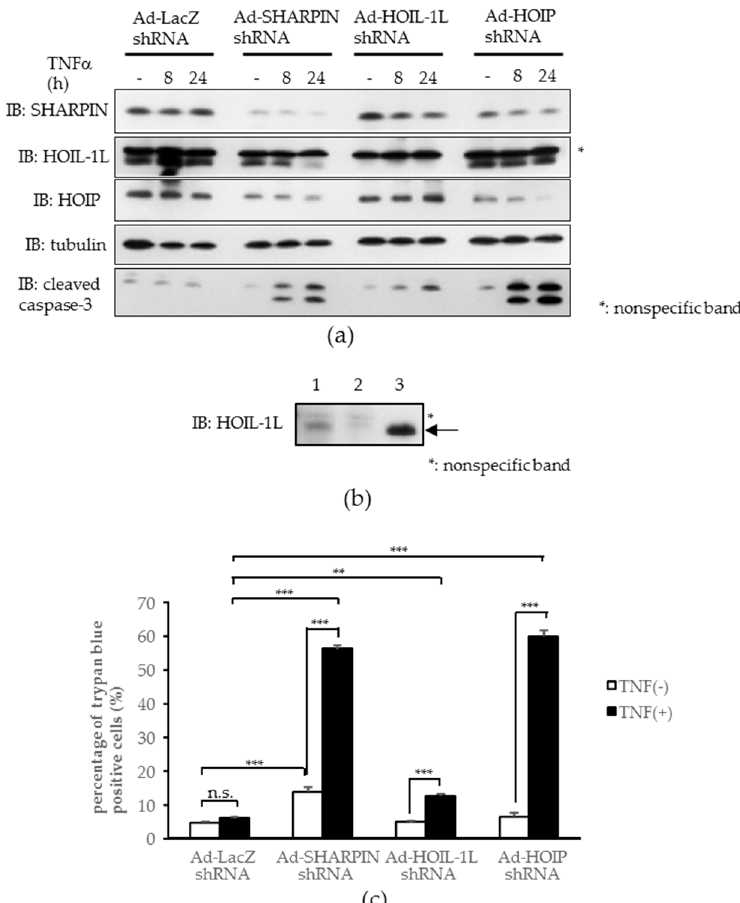
Figure 4. LUBAC insufficiency increases to tumor necrosis factor- α (TNF α )-induced apoptosis in Hepa1-6 cells. ( a ) Immunoblotting of each LUBAC component and cleaved caspase-3. Asterisks: non-specific bands; ( b ) Immunoblotting of HOIL-1L in Hepa1-6 cells. Lysates from Hepa1-6 cells, transduced with Ad-LacZ (1), Ad-HOIL-1L shRNA (2), or mouse HOIL-1L plasmid (3) were subjected to immunoblotting of HOIL-1L. Arrows: objective bands, asterisks: non-specific bands; ( c ) Quantitative cell death assay by trypan blue staining. ( n = 4) (** p < 0.01, *** p < 0.001)